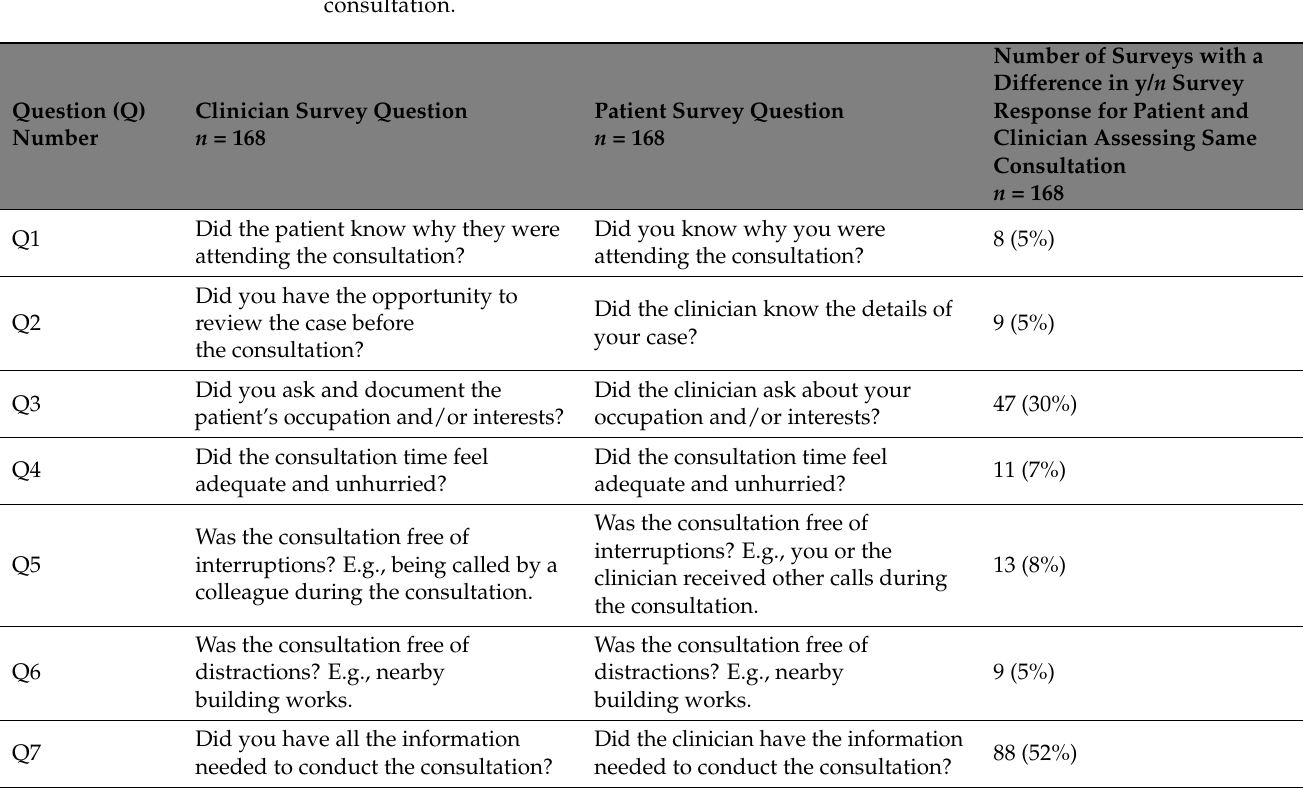
Table 3. Differences between clinician and patient survey responses when assessing the same